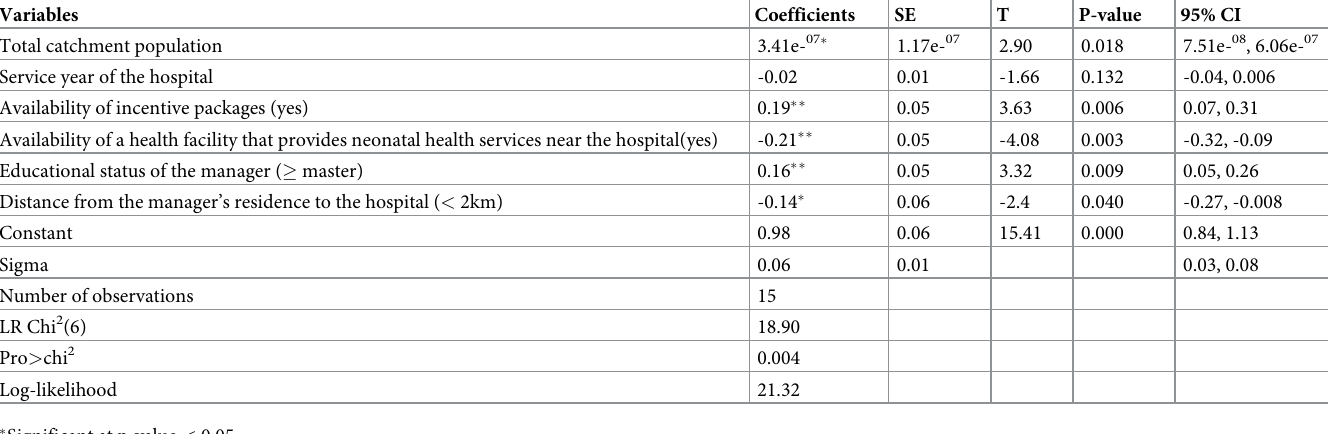
Table 5. Factors associated with the technical efficiency of neonatal health service among primary hospitals of three zones of Northwest Ethiopia, 2021 (N = 15